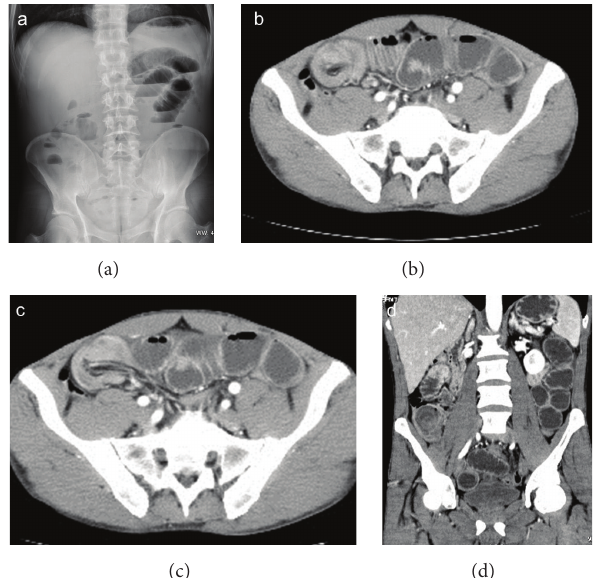
Figure 3: Enterocolonic (ileocaecocolonic) intussusception caused by intestinal lymphoma, with proximal bowel obstruction. Plain abdominal radiography (a) shows gas-fluid levels within distended small bowel loops. Intussusception is well depicted on axial CT scans (b, c) and coronal reformatting